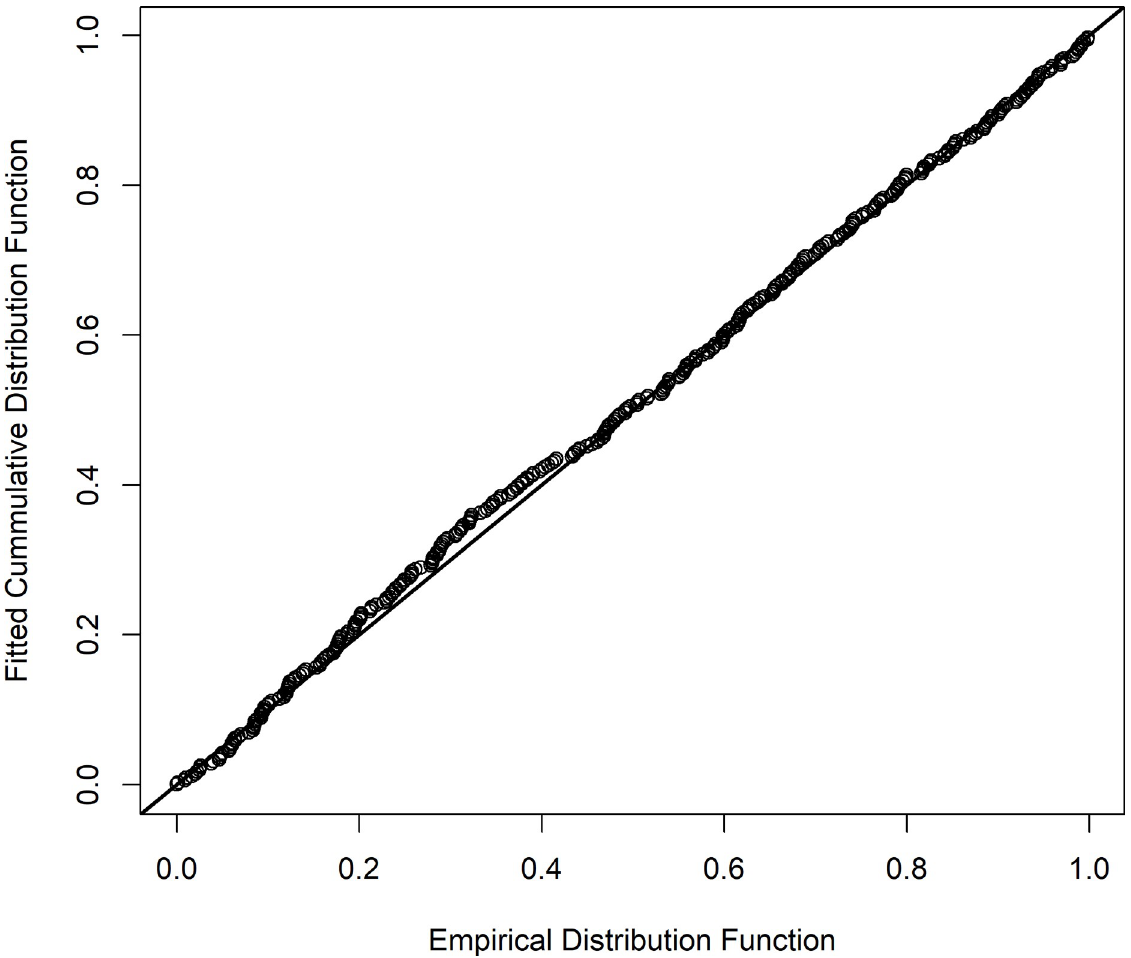
Fig 7. QQ-plot of the best multiple covariate distance sampling model of bear detection in Game Management Unit 9D and 10 combined, Southwest Alaska.